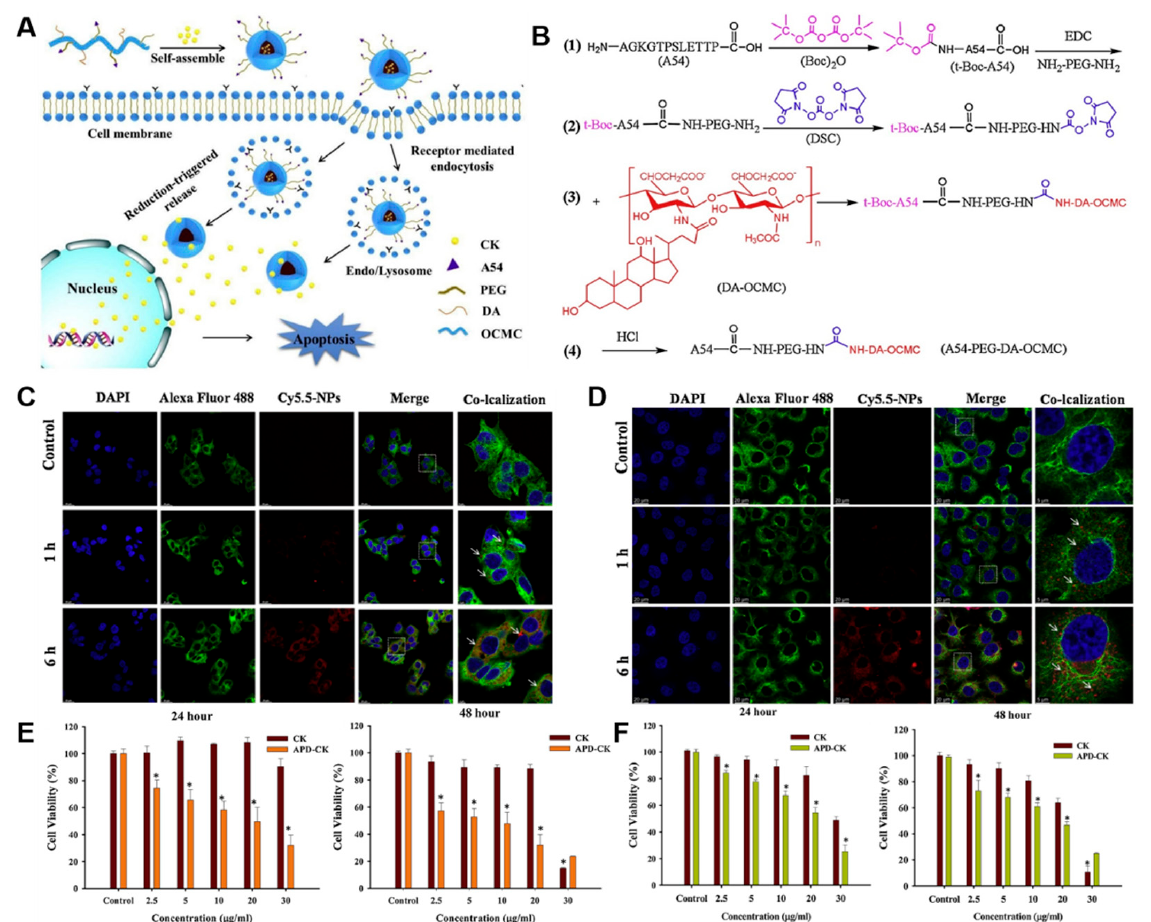
Figure 6. ( A ) Structural pathway of APD-CK inside the cell. ( B ) Conjugation of polymer (A54-PEG-DA-OCMC) before loading ginsenoside CK. Cellular uptake of APD-CK nanoparticles after incubating for 1 h and 6 h with ( C ) HepG2 and ( D ) Huh-7 cells. ( E ) In vitro cytotoxicity of normal ginsenoside CK and APD-CK against HepG2 cell line. ( F ) In vitro cytotoxicity of normal ginsenoside CK and APD-CK against Huh-7 cell line. Asterisks (*) denotes statistical significance difference compared with control group. Reprinted with permission from Ref. [117] . 2020, Elsevier Ltd.